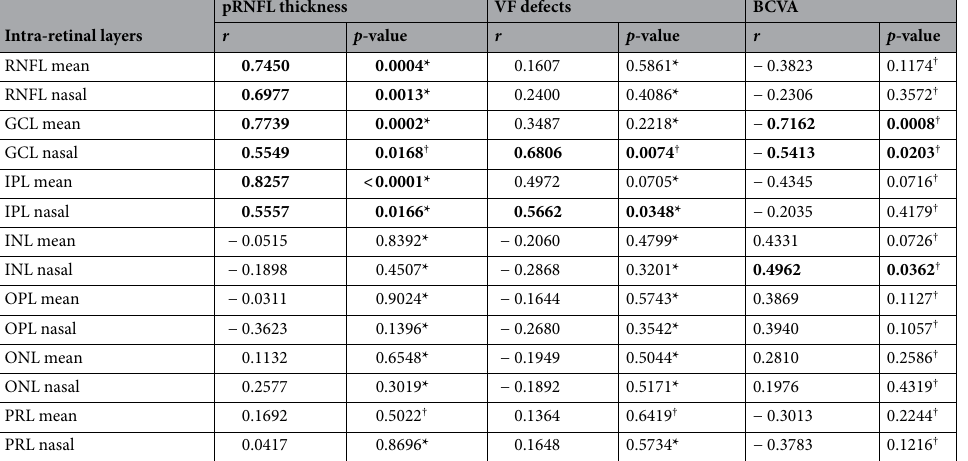
Table 4. Association analysis of postoperative intra-retinal layer thickness versus visual field defects, visual acuity, and peripapillary retinal nerve fiber layer thickness. Significant values are indicated in bold. RNFL retinal nerve fiber layer, pRNFL peripapillary retinal nerve fiber layer, VF visual field, MD mean deviation, BCVA best-corrected visual acuity, GCL ganglion cell layer, IPL inner plexiform layer, INL inner nuclear layer, OPL outer plexiform layer, ONL outer nuclear layer, PRL photoreceptor layer. *Pearson’s correlation analysis. † Spearman’s correlation